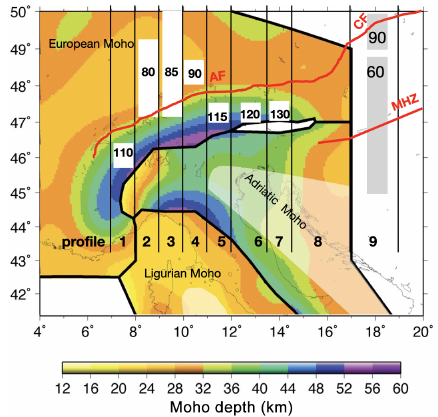
Figure 16. Moho map of Spada et al. (2013) indicating the provi- sional maximum recorded depth of the signals at the base of the NVG as marked in profiles 1–12 (b) . Small white bins in the back- ground of the numbers indicate steeply dipping NVG. Larger back- grounds indicate nearly horizontal